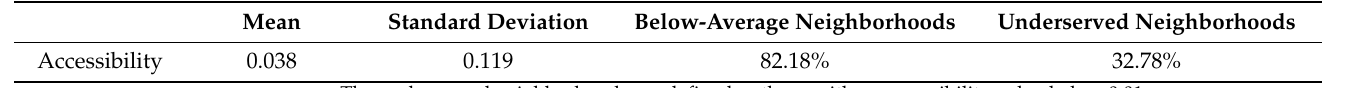
Table 3. Statistical analysis of neighborhood accessibility.